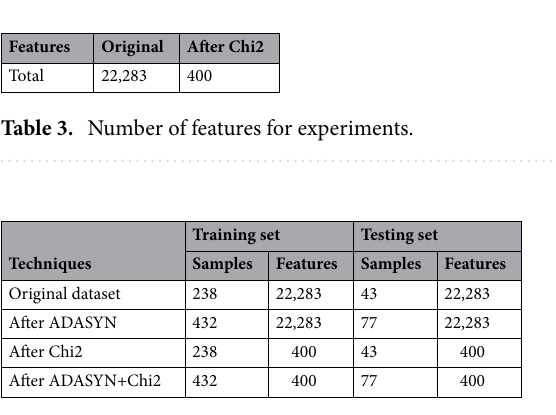
Table 4. Number of samples and features in training and testing